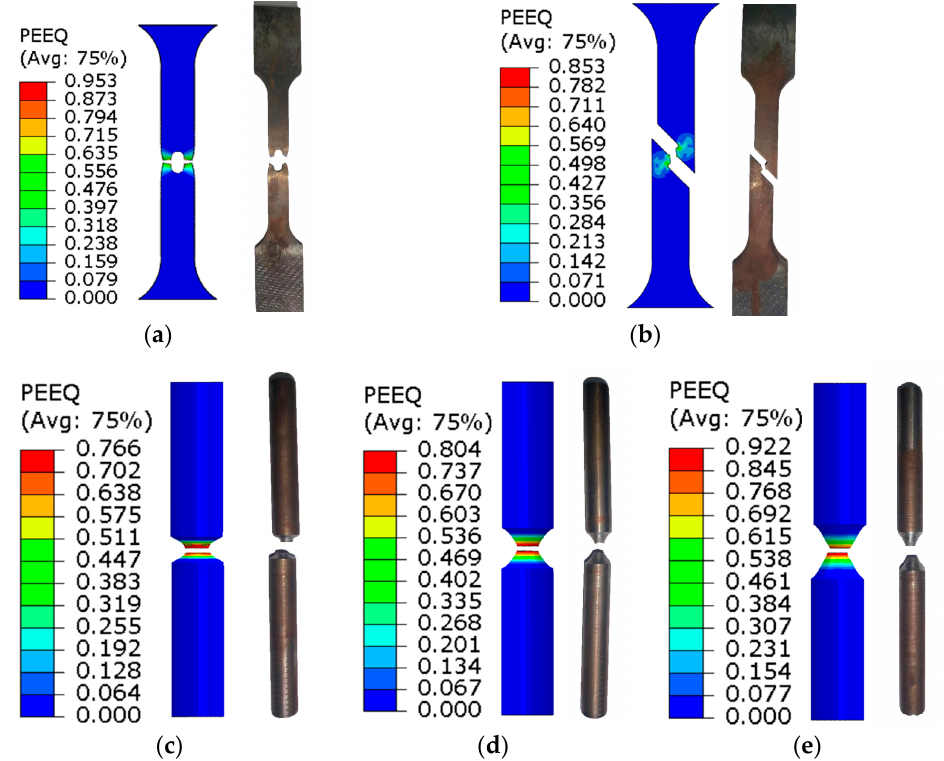
Figure 15. Comparison of experimental and simulated fracture morphology: ( a ) CH6, ( b ) FS, ( c ) NRB1, ( d ) NRB3, and ( e ) NRB5.